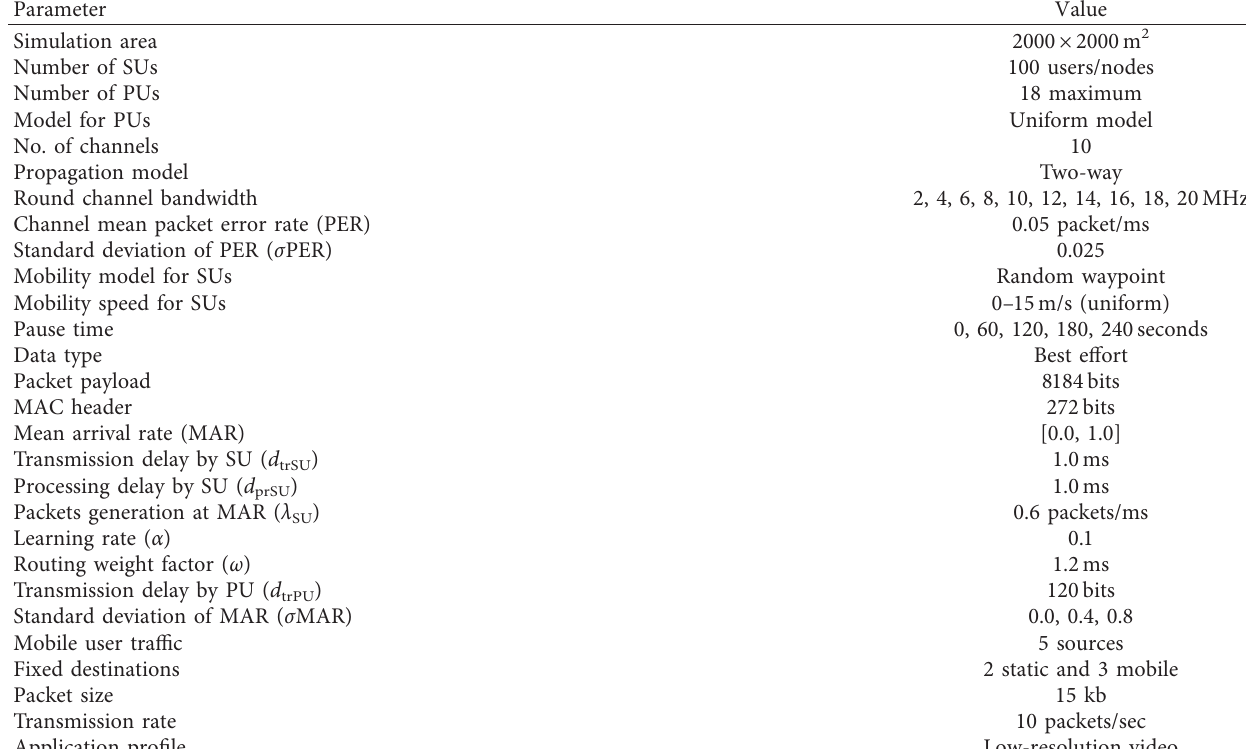
Table 1: Default simulation and structural